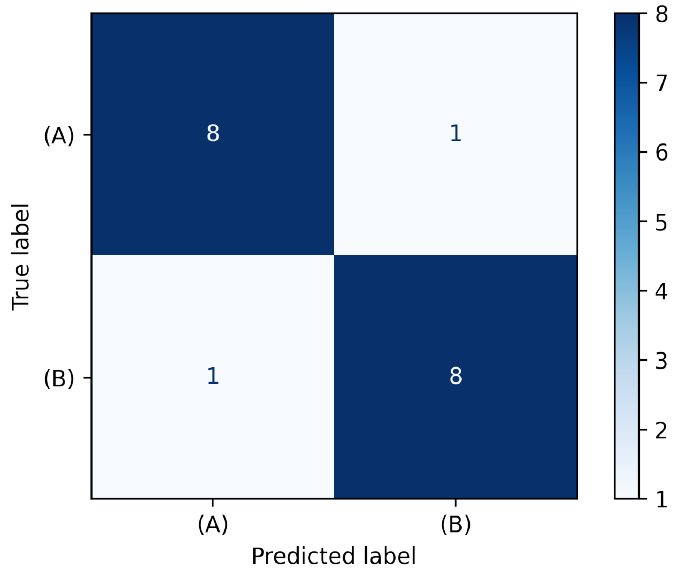
Figure 10. Confusion matrix for validation subsets of two chosen classes: ( A ) two teeth broken and ( B ) five teeth broken, comparing predictions with true